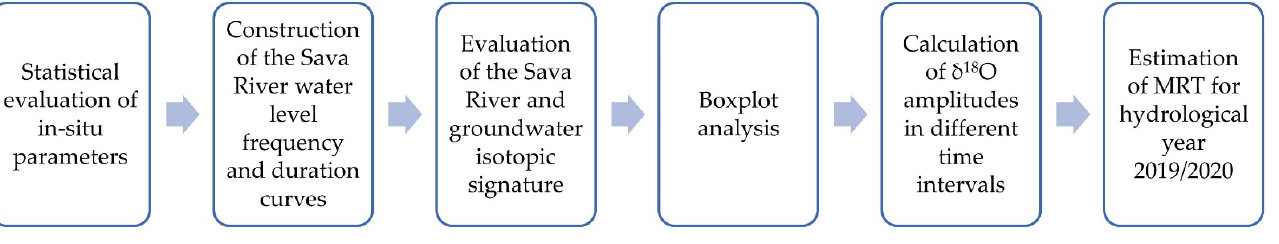
Table 1. Basic statistical values of in -situ parameters of the Sava River.